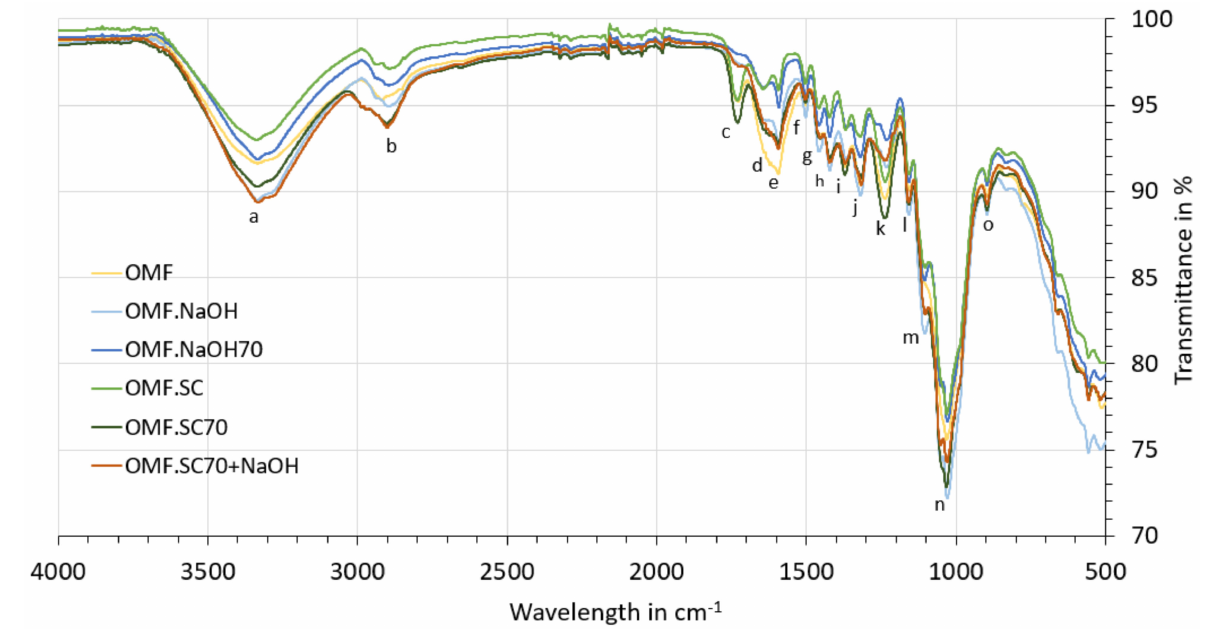
Figure 8. FTIR spectra for untreated and treated OM fibres.